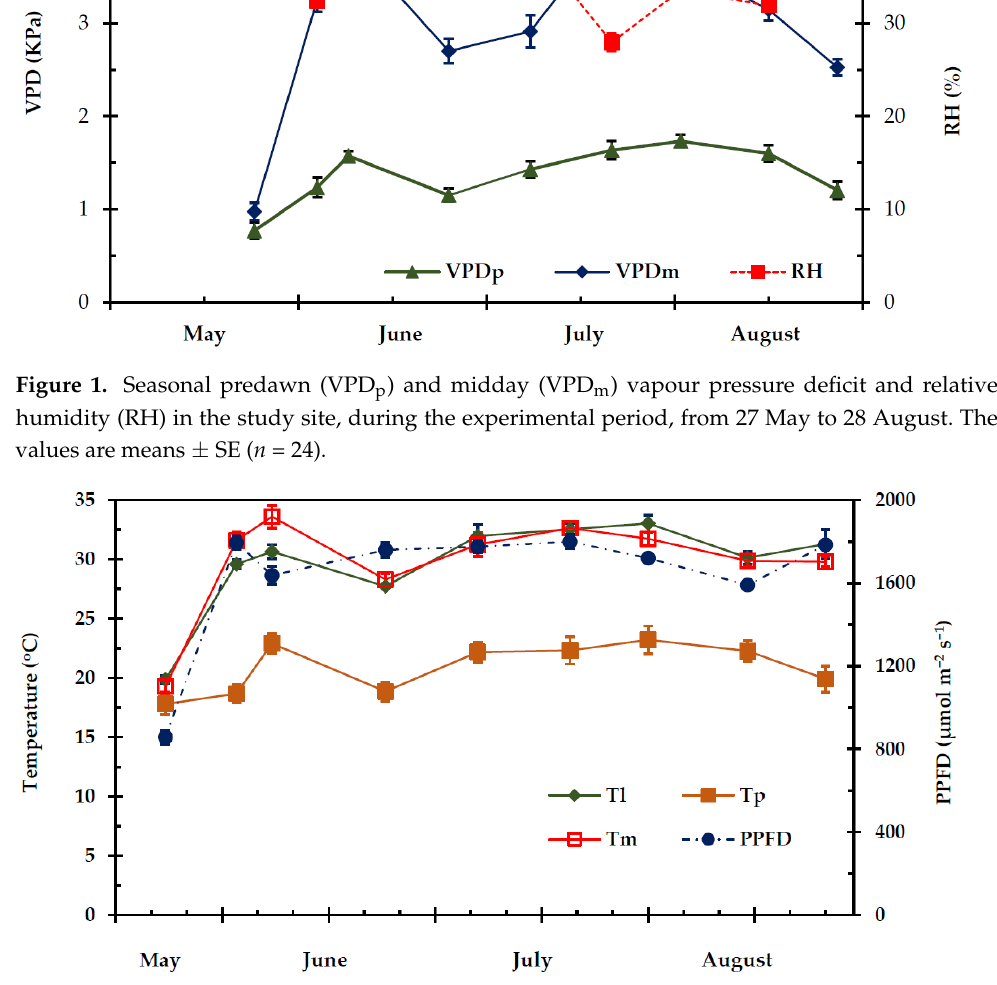
Figure 2. Seasonal Photosynthetic Photon Flux Density (PPFD), leaf temperature (T l ), morning (T p ) and midday (T m ) ambient air temperature during the experimental period from 27 May to 28 August. The values are means ± SE (n Tp,Tm = 24, n Tl = 48).